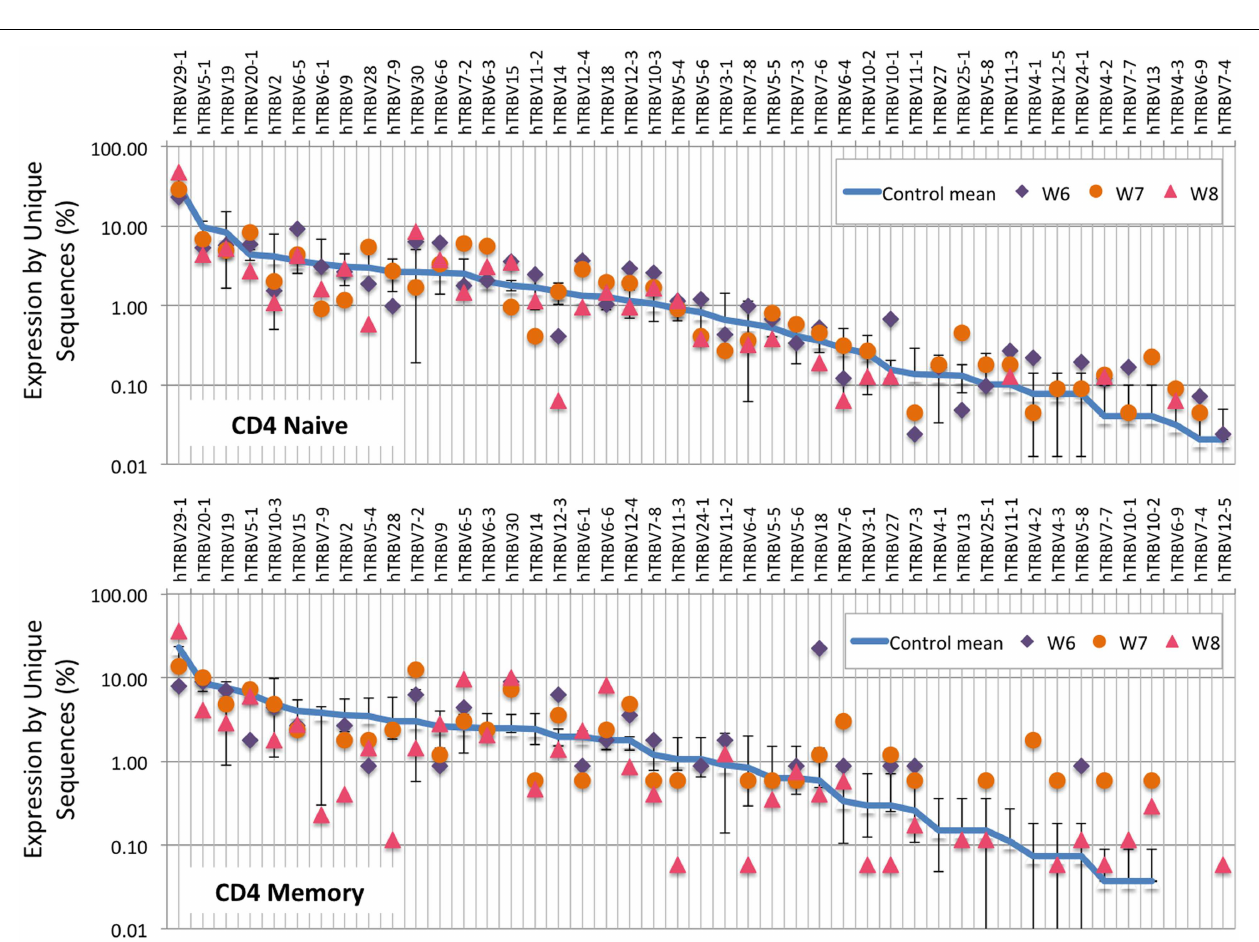
(top panel) or memory (bottom panel) lymphocytes.The blue line indicates the average frequency of the two control patients, and the error bars indicate the SD of the frequency of the